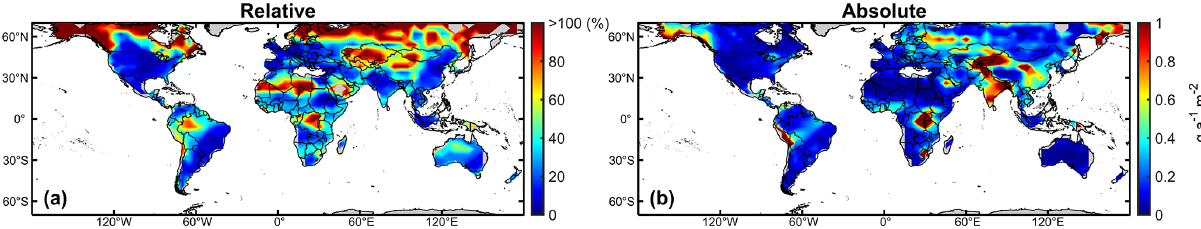
Figure 7. Spatial distribution of TDE (a) relative and (b) absolute uncertainty during 2008–2018. Absolute uncertainties are derived as half of the perturbation ensemble range (Table 1), and relative uncertainties are computed by normalizing absolute uncertainties with ensemble averages.